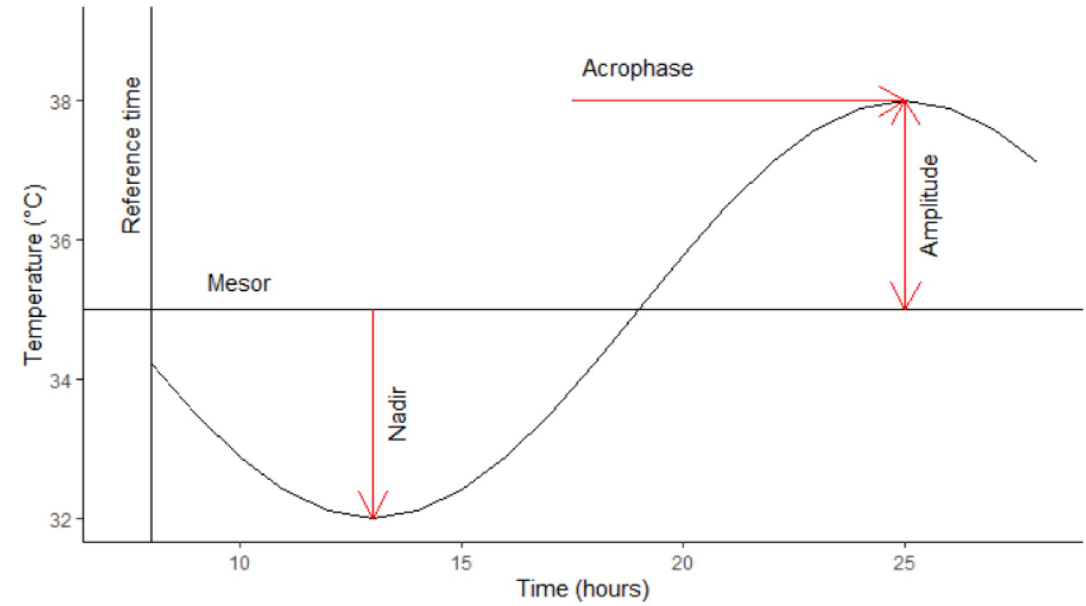
Figure 5. Interpretation of Cosinor parameters Mesor (rhythm-adjusted mean), Amplitude (half the extent of predictable variation within a cycle), Acrophase (the time of overall maximum values) and Nadir (the time of overall minimum values). Figure produced using R Core Team (2021). R: A language and environment for statistical computing. R Foundation for Statistical Computing, Vienna, Austria. URL https:// www.R- proje ct.